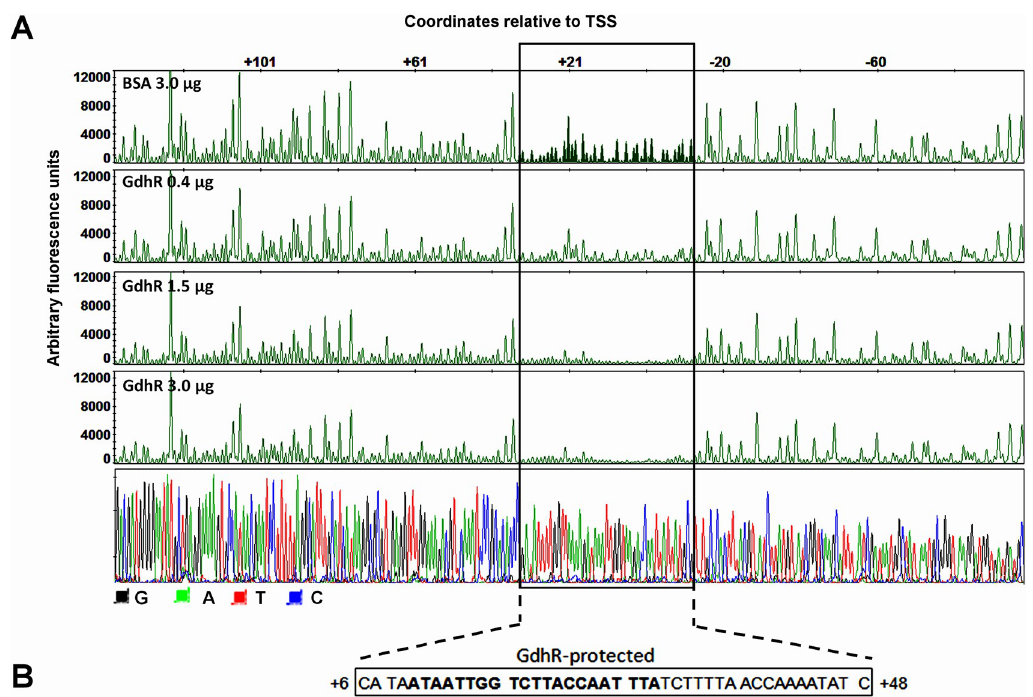
Fig 5. GdhR protects a DNA sequence near the lctP promoter. A. A DNA fragment spanning the lctP promoter region from nucleotide -192 to +381 (relative to the TSS) was fluorescently-labeled with 6-FAM (coding strand) and HEX (template strand) and incubated with BSA (control reaction) or GdhR prior to digestion with DNase I. The DNase I digestion products were analyzed by capillary electrophoresis. The fluorescence signal corresponding to the HEX probe is shown on the y axis of each electropherogram. Fragment coordinates (relative to the TSS) are shown along the top of the BSA electropherogram. Three electropherograms corresponding to 0.4, 1.5 and 3.0 μ g of GdhR reactions are shown. The lctP promoter region protected by GdhR is boxed. Dideoxy sequencing reactions were manually-generated using the primer HEX-lctP-DNase and a PCR fragment encoding lctP promoter from -192 to +381 (bottom panel). B. DNA sequence of the GdhR-protected region on both strands (the electropherogram corresponding FAM-labeled coding strand is shown in S5 Fig). The consensus DNA-binding motif of the FadR-family of regulators is shown in bold font.